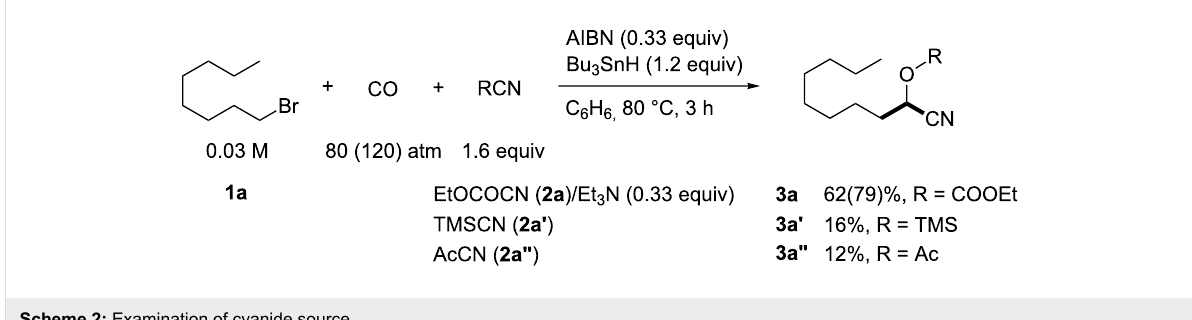
Scheme 2: Examination of cyanide